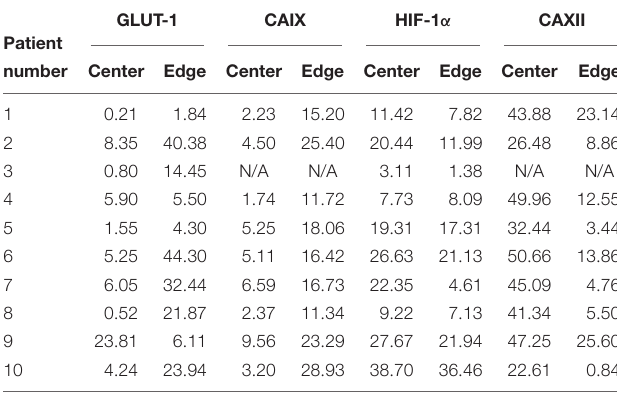
TABLE 2 | Average percent positive expression of GLUT-1, CAIX, HIF-1 α , and CAXII in the center and edge of the tumor. GLUT-1 CAIX HIF-1 α CAXII